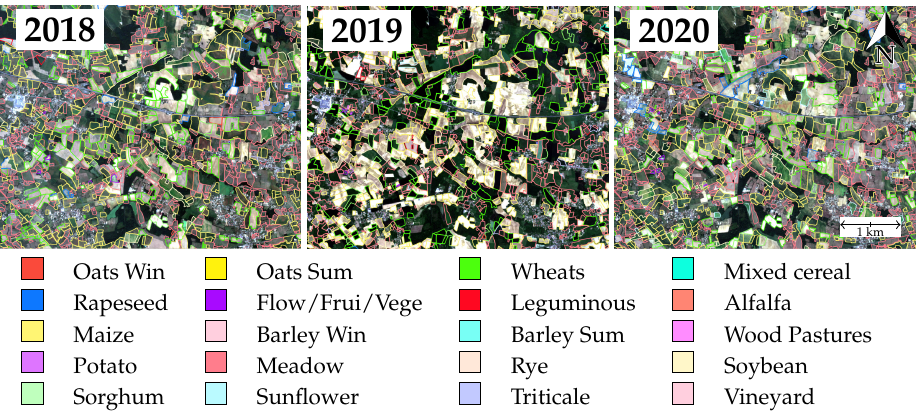
Figure 1. Multi-Year Sentinel-2 Data. Details of our area of interest for the three years studied in this article. The crop type of each parcel is represented by the color of a polygon following their contour according to the legend above. This color code is used throughout this article for all figures representing cultivated